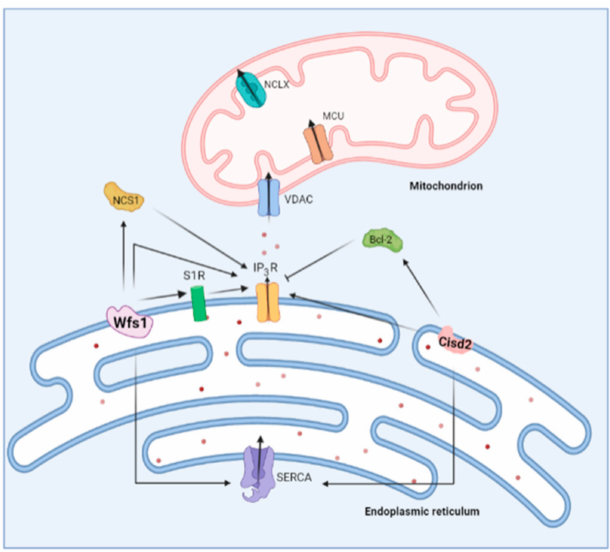
Figure 5. Overview of the role of two Wolfram syndrome proteins on ER Ca 2+ handling. Wolframin (Wfs1) stimulates IP 3 R-mediated Ca 2+ release both directly and via Neuronal Ca 2+ Sensor 1 (NCS1). On the other hand, Cisd2 also interacts with the IP 3 R in a direct and indirect manner. Cisd2 modulates B-cell lymphoma 2 (Bcl-2), which is a known inhibitor of the IP 3 R. Both Wfs1 and Cisd2 were shown to interact with sarco-endoplasmic reticulum ATPase